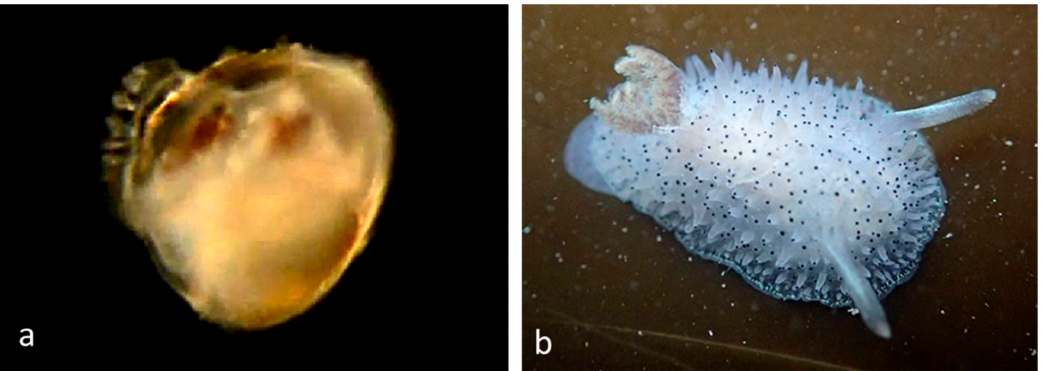
Figure 12. Family Onchidorididae . Black-tipped Spiny Doris, Acanthodoris rhodoceras . ( a ) Larva CCDB 31597 D11 from Balboa at Coral. ( b ) Juvenile from Cabrillo Beach, Los Angeles County, CA. (http: //nathistoc.bio.uci.edu/Molluscs/Acanthodoris%20rhodoceras/index.html accessed on 1 October 2022).